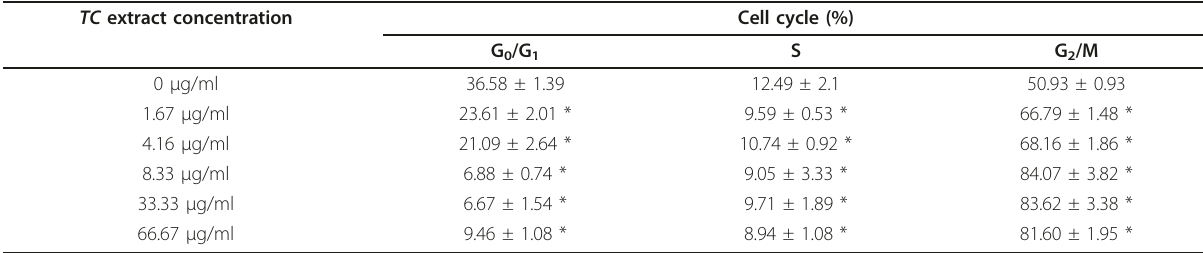
Cell cycle distributions in PC-3M-1E8 cells exposed to TC extract for 24 h, as determined by flow cytometry using propidium iodide staining. Values are mean ± SEM of 3 experiments. *Significantly different from 0 μ g/ml (P <